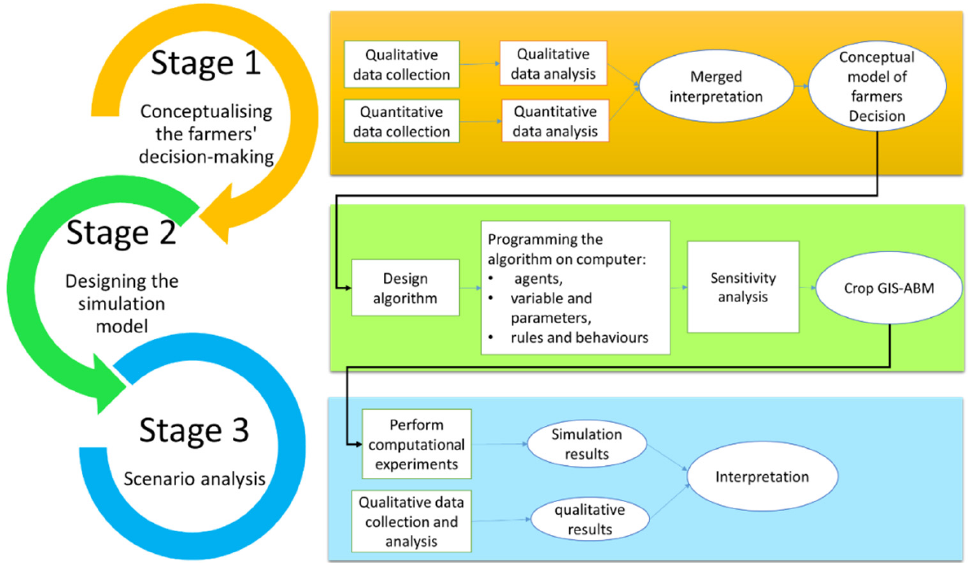
Figure 1. Key stages in this study: model conceptualisation, development of the simulation model and scenario analysis.